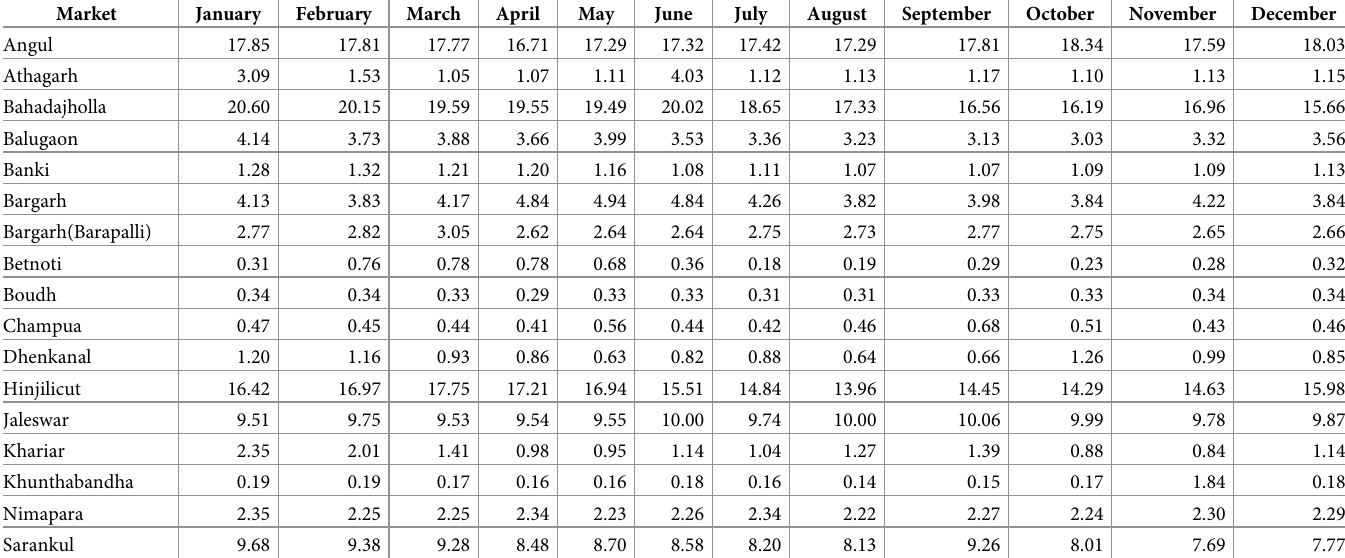
The stochastic model i.e. ARIMA and machine learning techniques e.g. RF, SVR, GRNN and GBM as described in methodology sections have been fitted for the data under consideration. Table 2. Average monthly arrival of brinjal in important markets in Odisha.